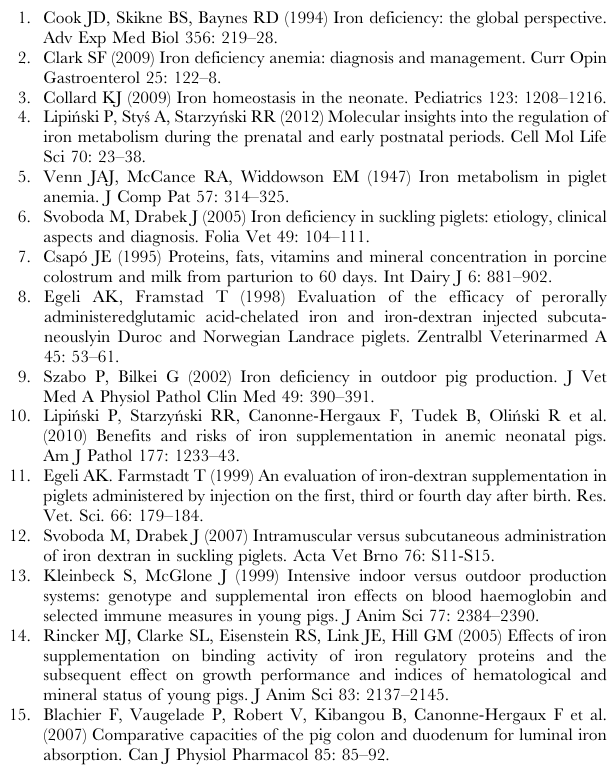
Figure S1 Dilution linearity of the piglet hepcidin-25 assay. A piglet plasma sample containing 8.3 nM (sample content 1.00) Hepcidin-25 was diluted 2, 3, 5 and 10 times in binding buffer (sample content 0.50, 0.33, 0.20 and 0.10, respectively) and applied to WCX-TOF MS. The measured hepcidin-25 values are indicated in nM. Dilution linearity: R 2 =